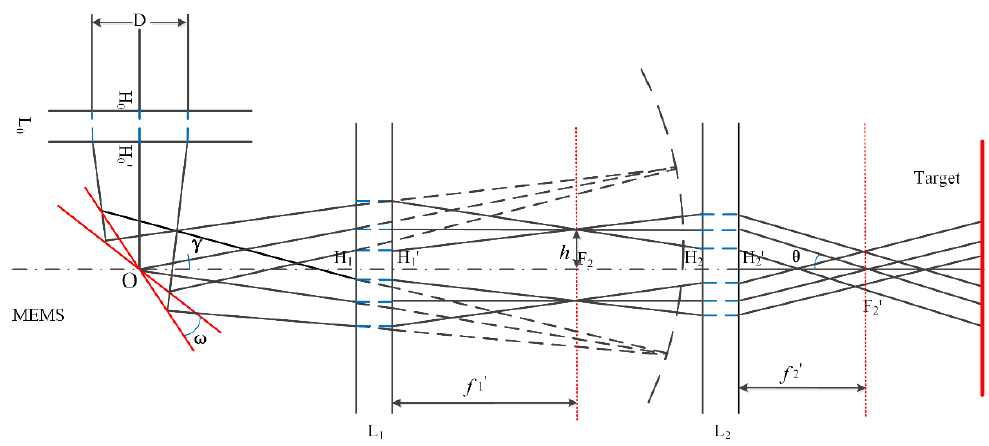
Figure 2. Schematic diagram of MEMS scanning system.